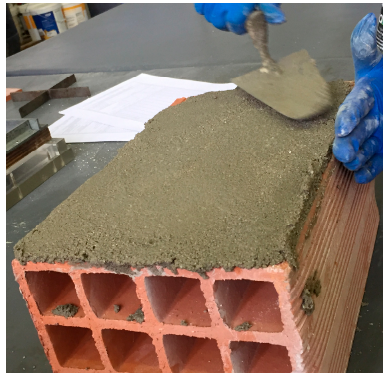
Figure 2. Mortar application on a brick.